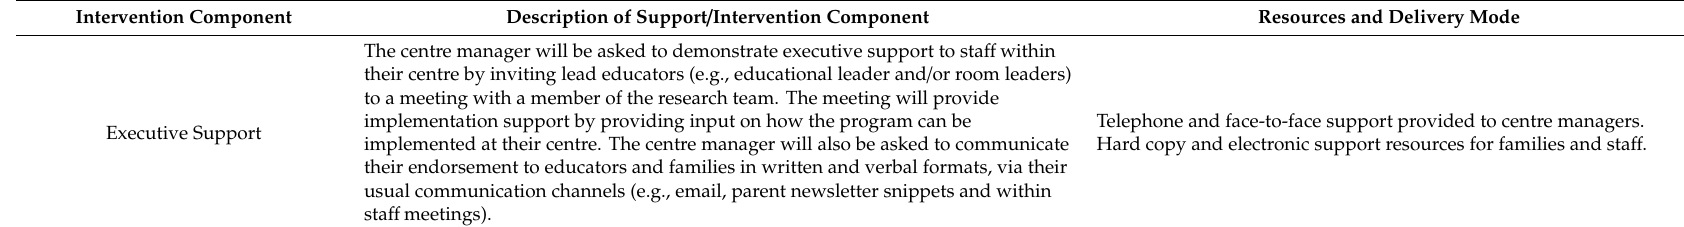
Table 2. Support delivered as part of the Everybody Energise